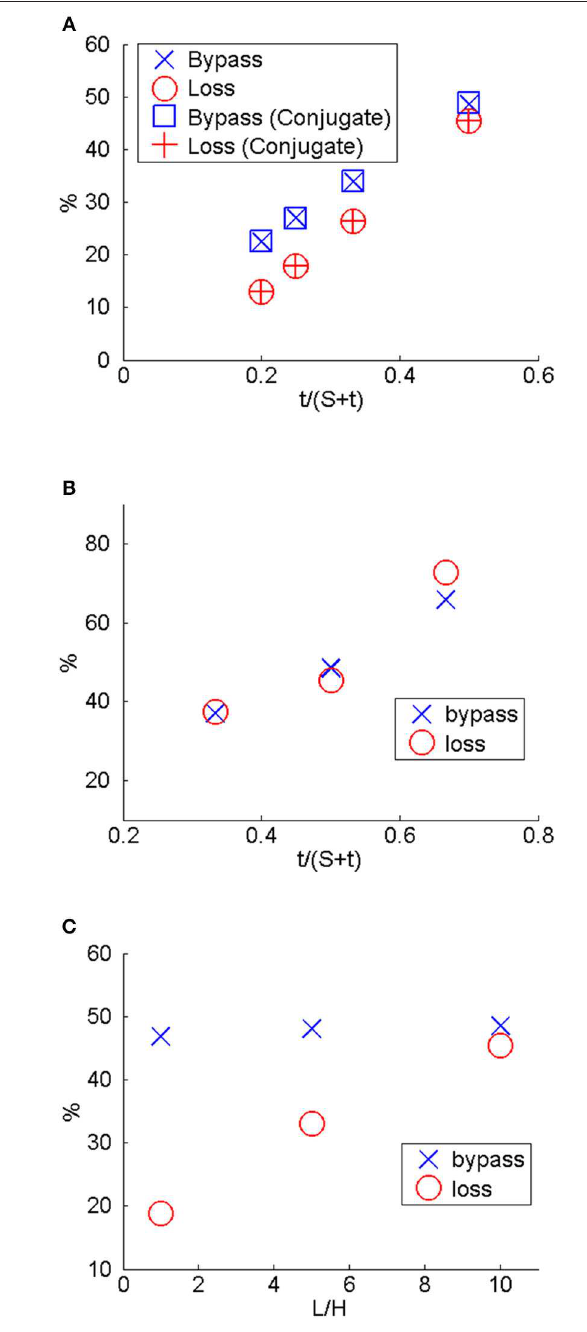
FIGURE 6 | Bypass and loss as a function of: (A) S/H and conjugate vs. isothermal (Cases 4, 7–9). (B) t/H (Cases 7, 10, 11). (C) L/H (Cases 7, 12, 13).